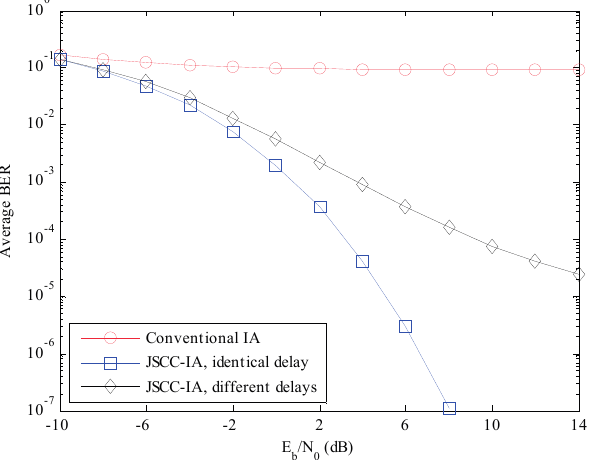
Figure 5. The average experimental BER performances of the conventional IA scheme and the JSCC-IA schemes with identical/different propagation delays in the (4 × 4, 1) 20 symmetric